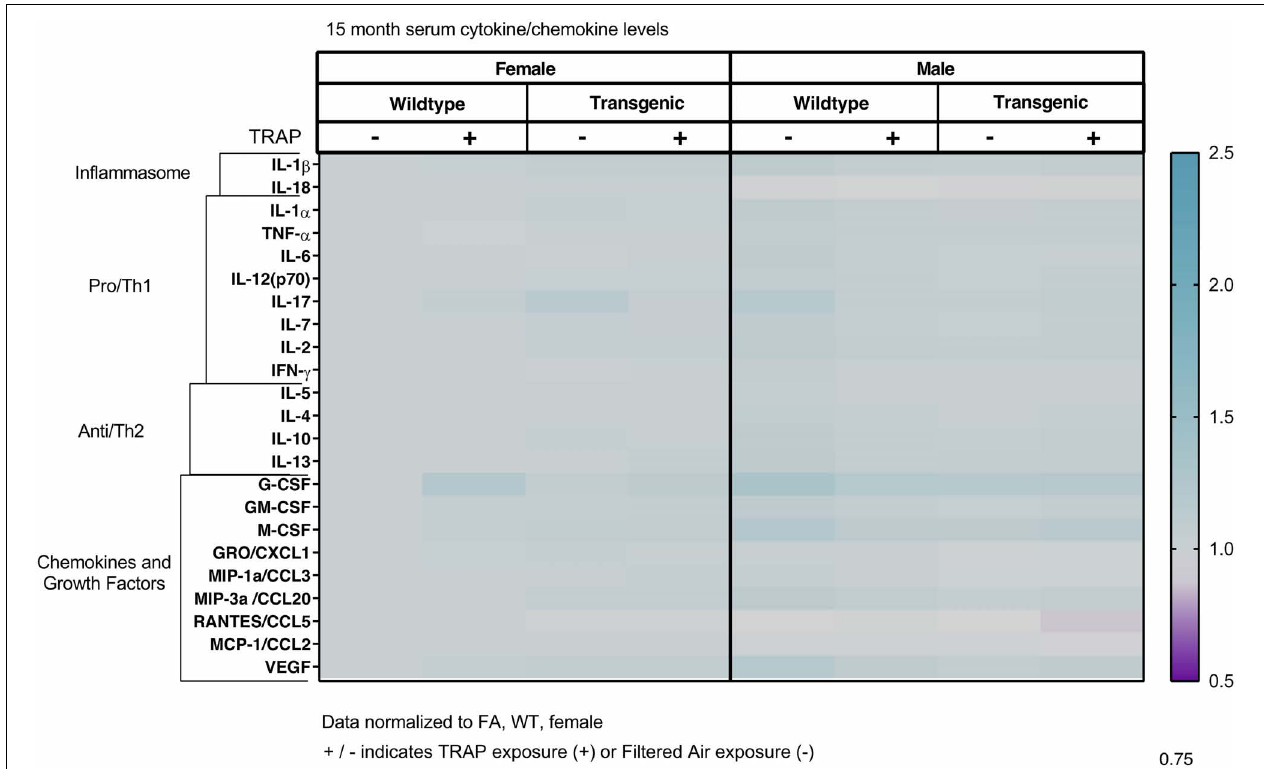
FIGURE 5 | Heat map representation of serum cytokine, chemokine, and growth factor changes in response to TRAP in 15-month old TgF344-AD and WT rats. Serum levels of cytokines and growth factors in TgF344-AD and WT rats exposed to FA or TRAP for 14 months were analyzed using multiplex technology. For each analyte, individual values were normalized to the mean level of that same analyte in sera from female FA WT animals. Purple indicates normalized protein levels < 1.0; turquoise indicates normalized protein levels > 1.0. ± indicates exposure with + identifying TRAP-exposed animals; - indicating FA-exposed animals; n = 4–5 animals per group (duplicate samples were analyzed for each animal). Non-normalized cytokine values for female FA WT animals are provided in Supplementary Table 1